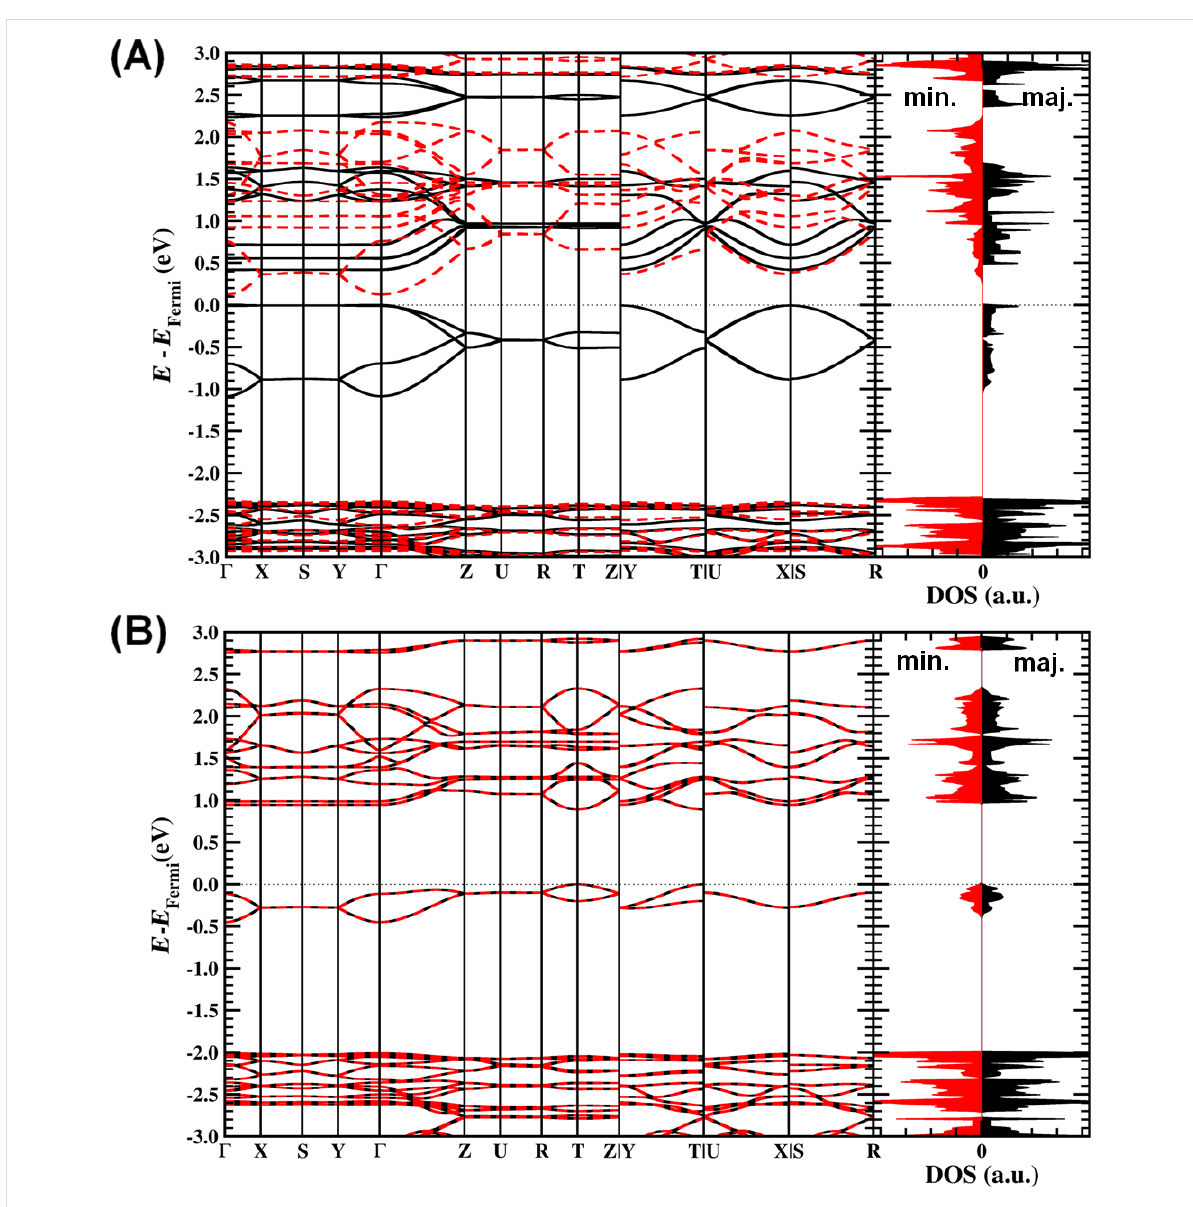
Figure 4: Band structure and density of states (DOS) near the Fermi level for the FM (A) and AF3 (B) spin configurations. Solid black/dashed red curves indicate the bands for the majority/minority spin components, respectively.